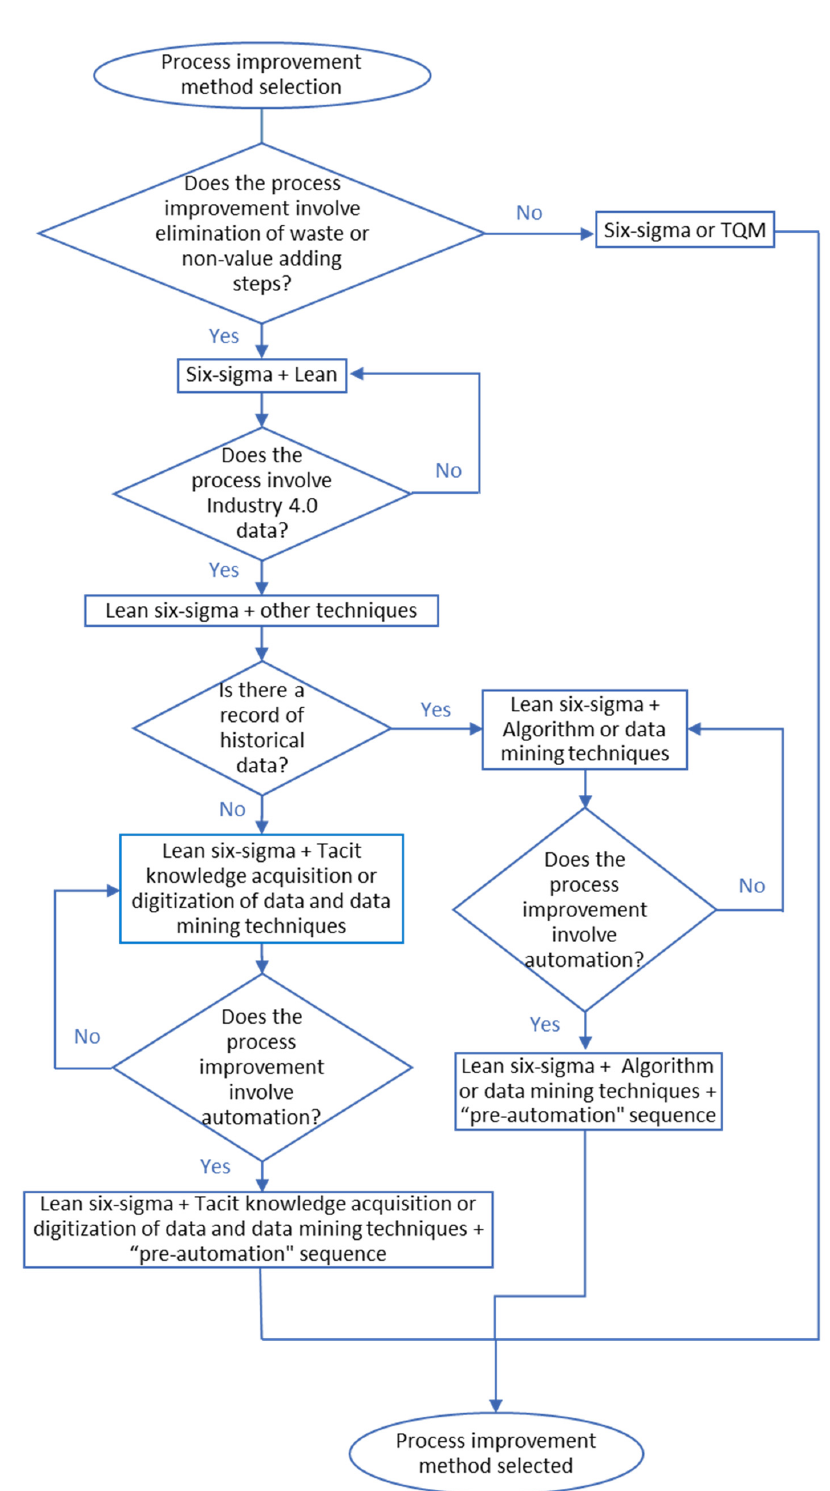
Figure 1. Process improvement methodology selection flowchart.